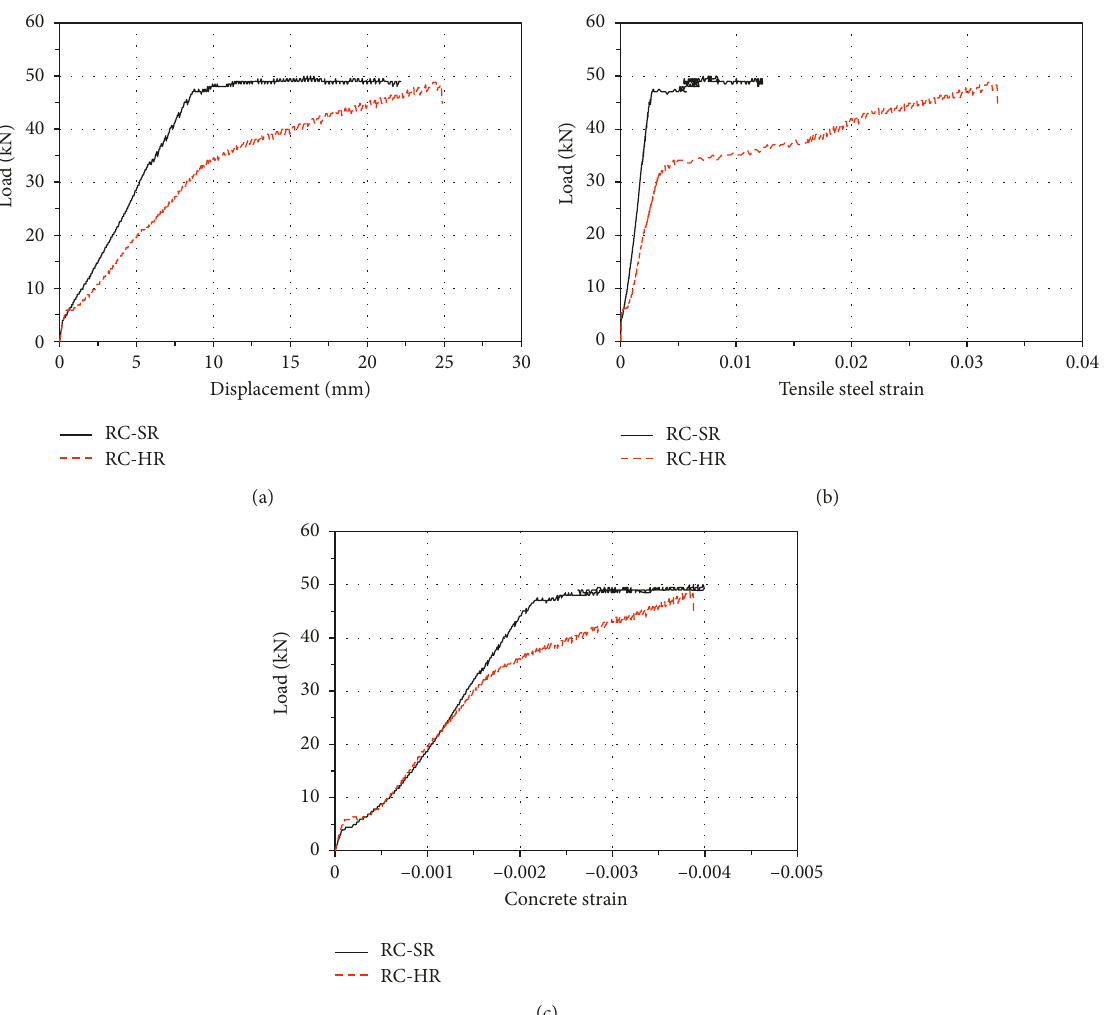
Figure 6: Comparison of static test results of RC beam specimens reinforced by the steel rebar (RC-SR) and by the hybrid FRP-steel rebar (RC-HR): (a) load-deflection curves measured at midspan [25]; (b) load-tensile strain curves measured in longitudinal reinforcement; (c) load-concrete compressive strain curves.